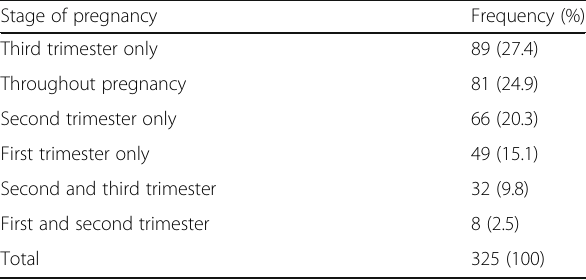
Table 6 Use of CAM by stage of pregnancy. ( n = 325) Stage of pregnancy